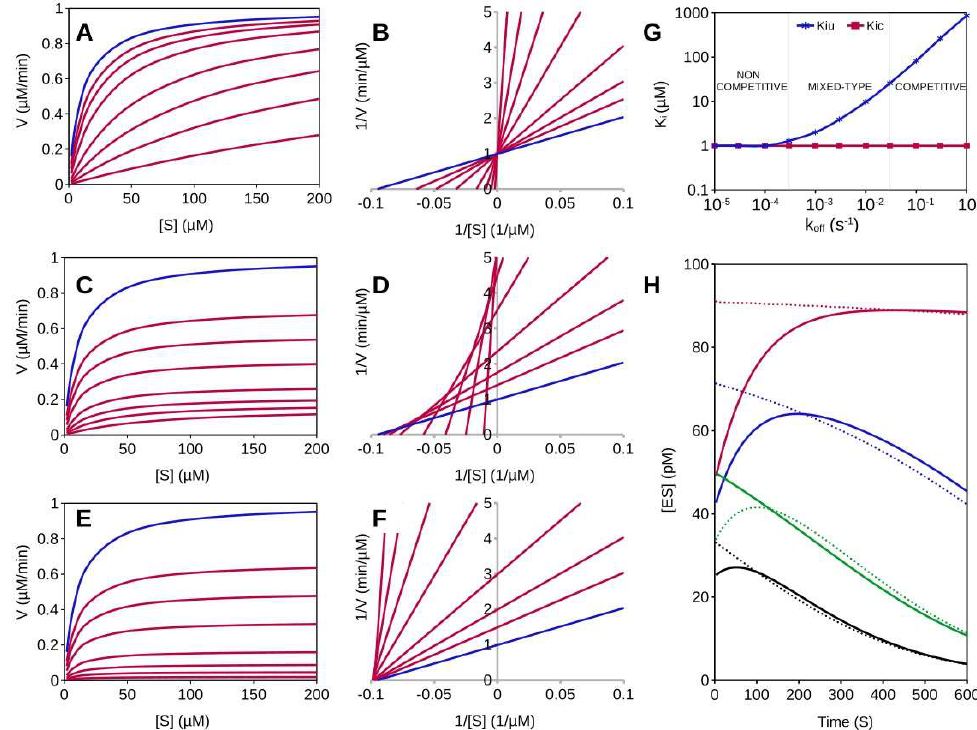
Figure 3. Analysis of synthetic kinetic data. Initial velocities were computed for an enzyme with K m = 10 µM and k cat = 1000 s −1 inhibited by three different competitive inhibitors with K i = 1 µM. An extensive E-I pre-incubation of 10 6 s was allowed before the start of the reaction with substrate. ( A , C , E ) Initial velocity vs. [S] curves; for all curves [E] = 100 pM and [S] = 2, 5, 10, 20, 50, 100, 150, 200 µM. For each inhibitor [I] = 0, 0.5, 1, 2, 5, 10, 20 and 50 µM. Blue traces are for non-inhibited reactions. ( A ) fast unbinder ( k off = 10 2 s −1 ), ( C ) intermediate unbinder ( k off = 3·10 −2 s −1 ), ( E ) slow un- binder ( k off = 10 −4 s −1 ). ( B , D , F ) Lineweaver–Burk plots; for the fast dissociating inhibitor the inhibition is pure competitive ( B ) while the slow unbinder gives a plot typical of noncompetitive inhibition ( F ). For the intermediate inhibitor ( D ) a characteristic plot is obtained with an intersection between lines that shifts toward the 1/V axis as the [I] increases. For data point at low [I], the shift toward 1/V axis is less pronounced and the plot is consistent with mixed-type inhibition. ( G ) Emergence of the apparent uncompetitive inhibition component as a function of k off ; for k off larger than 3×10 −2 s −1 the inhibition as expected is competitive ( K iu >> K ic ). For k off smaller than 3×10 −3 s −1 the inhibition seems pure noncompetitive ( K iu = K ic ). Artifacts suggesting a mixed-type inhibition occur for k off in the range ~3×10 −4 –3·10 −2 s −1 , where the corresponding apparent K iu value varies from 1· K ic to ~20· K ic . ( H ) Time course of the ES complex formation for substrate initiated reactions. The enzyme was pre-incubated with a slow dissociating inhibitor ( k off = 10 −2 s −1 , continue lines) or with a fast dissociating inhibitor ( k off =10 3 s −1 , dashed lines). For all curves [E] = 100 pM and [I] = 1 µM. Four different substrate con- centrations were assayed, 10 µM (black lines), 20 µM (green lines), 50 µM (blue lines) and 200 µM (red lines). It should be noted how the discrepancy between continuous and dashed lines at time t 0 are larger for the curves at high [S]. For reactions at saturating initial [S] (red continue line), the velocity approaches the steady-state rate (red dashed line) after ~350 s of reaction. However, for reactions at lower initial [S] due to substrate depletion, the steady-state rate cannot be detected. A gradual transition from competitive to noncompetitive occurs within k off values in the 3×10 −2 –3×10 −4 s −1 range, where the inhibition appears to be mixed-type and K iu decreases with the inhibitor residence time. Then it turns purely noncompetitive, with K ic = K iu , for k off smaller than 3·10 −4 s −1 . The explanation of this apparent paradox is indeed trivial. When